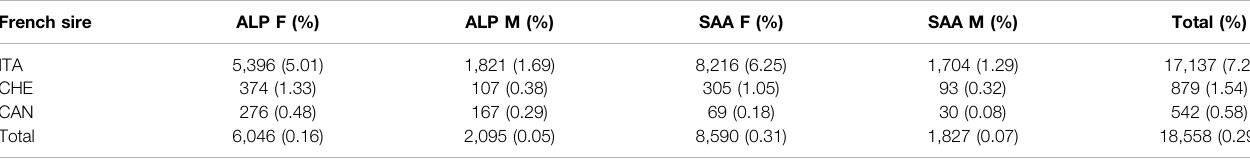
TABLE 3 | Number of Canadian (CAN), Italian (ITA), and Swiss (CHE) animals with a French (FRA) sire for the Alpine (ALP) and Saanen (SAA) breeds according to the sex of the animals (M for male and F for female). The proportion of animals relative to the native pedigree is given in parentheses.